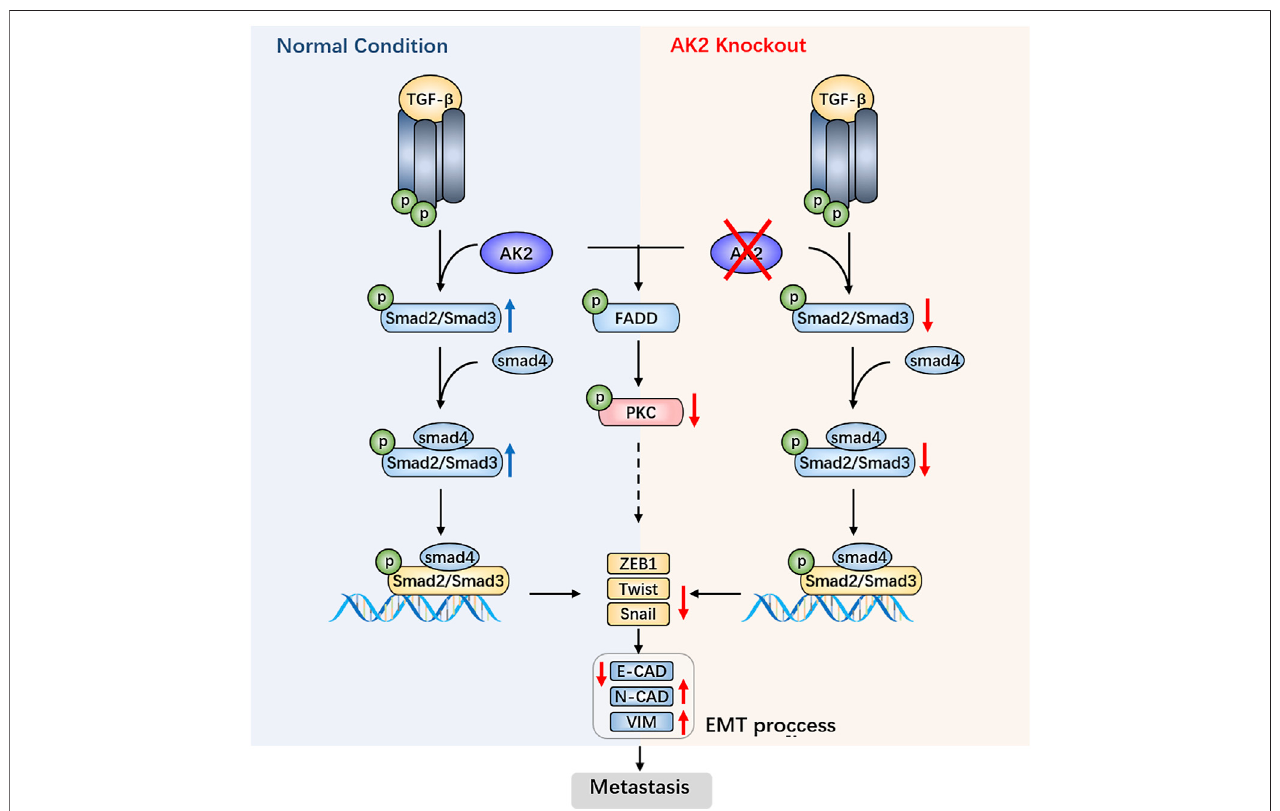
FIGURE 6 | AK2 promotes the migration and invasion of lung adenocarcinoma by activating TGF- β /Smad pathway.